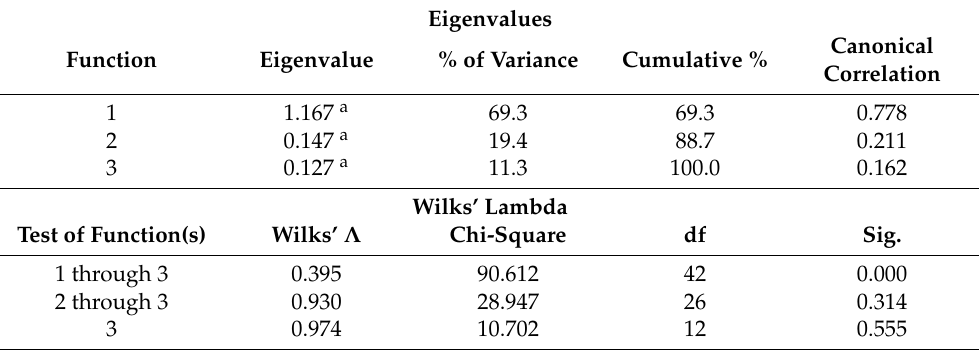
Table 7. Synopsis of canonical discriminant functions (chi-square, Eigenvalues and Wilks’s Λ )